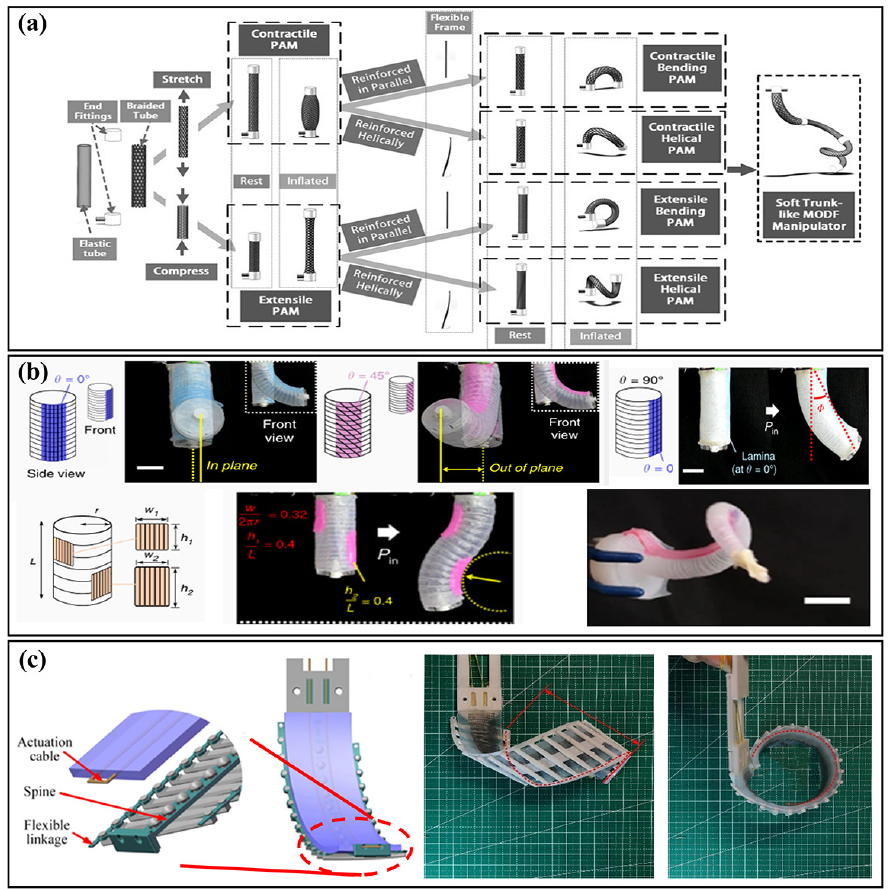
Figure 13. ( a ) The realization process of pneumatic artificial muscle composite motions [108]. ( b ) Mo- tion effects of three angle fiber direction composite laminae adhered on a soft actuator [109]. ( c ) The mechanism of a scaffold reinforcement soft actuator and the effect of different motions by changing the scaffold direction